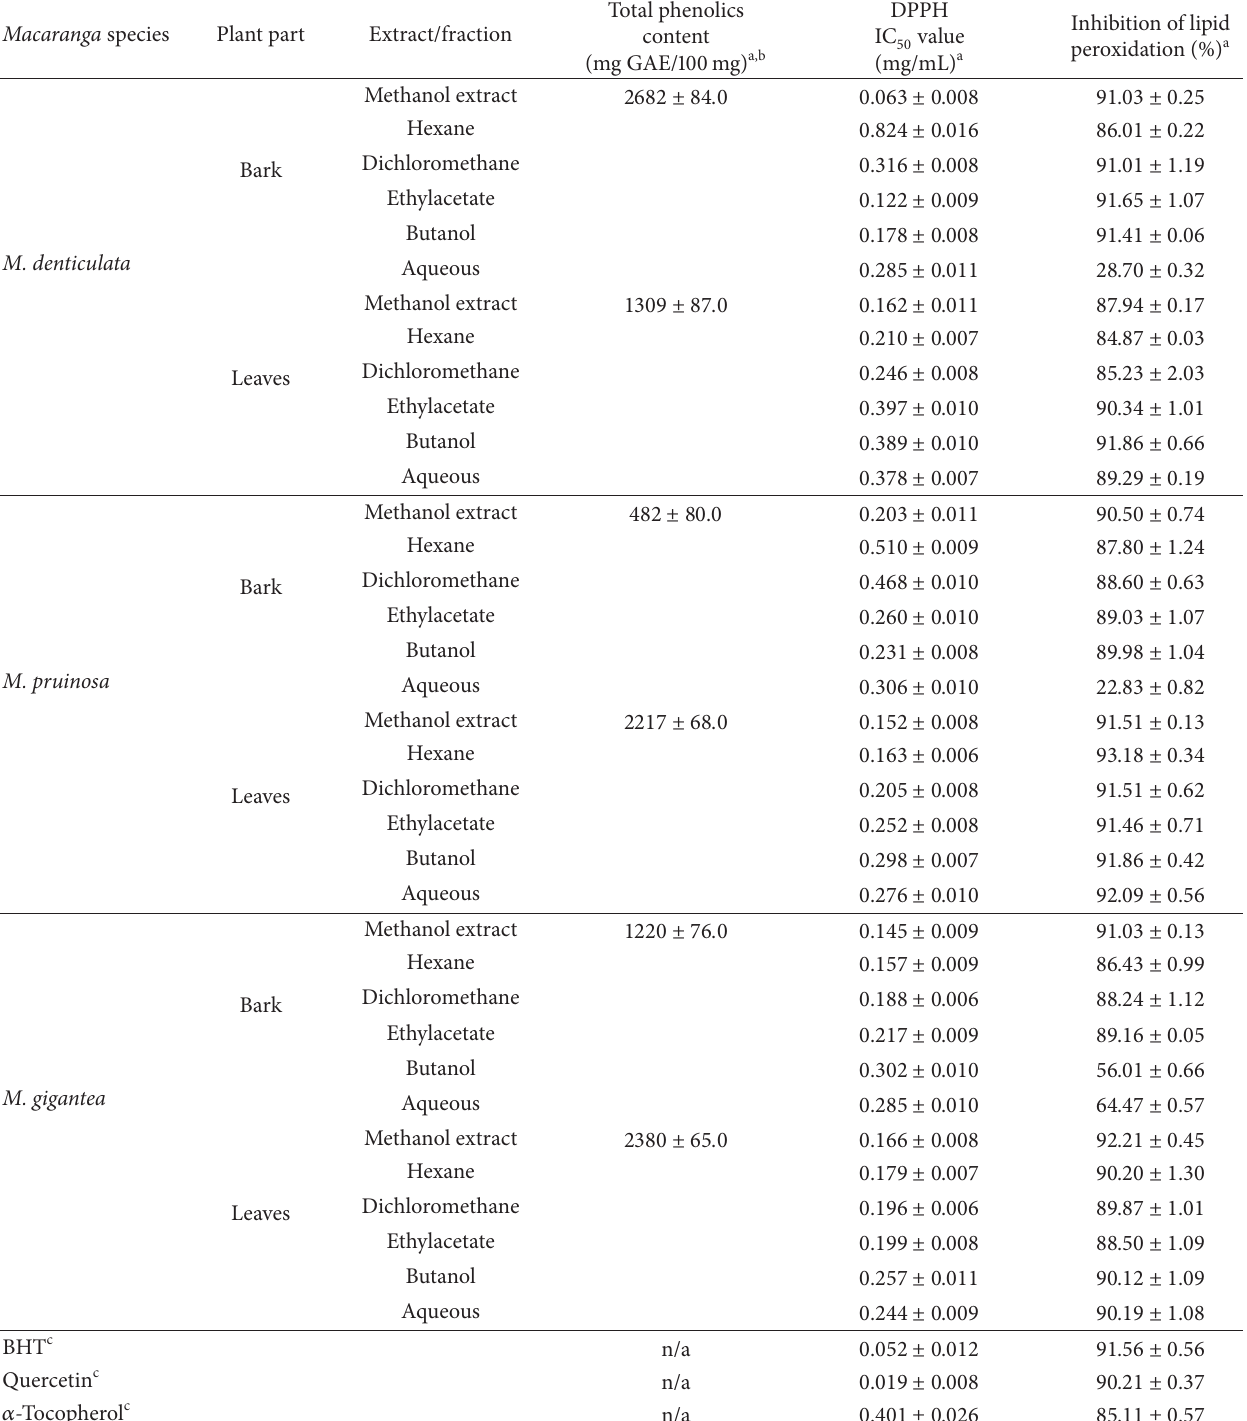
Table 1: Total phenolic content and antioxidant activity (DPPH and lipid peroxidation) of extracts and different polarity fractions of Macaranga